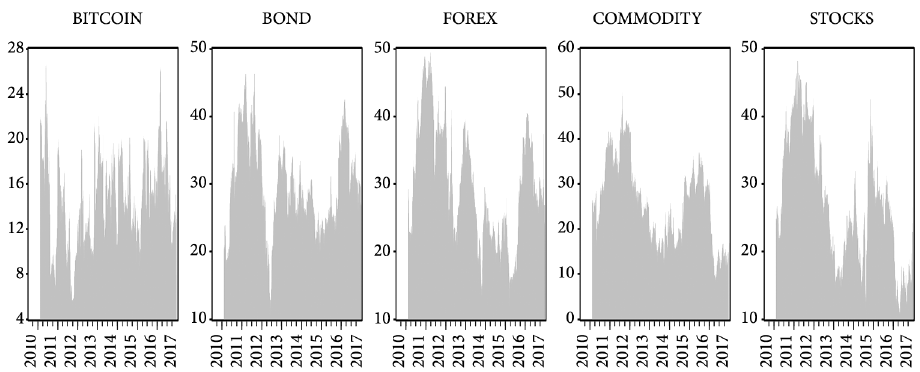
Figure 2. Directional volatility spillover from U.S. bitcoin and financial